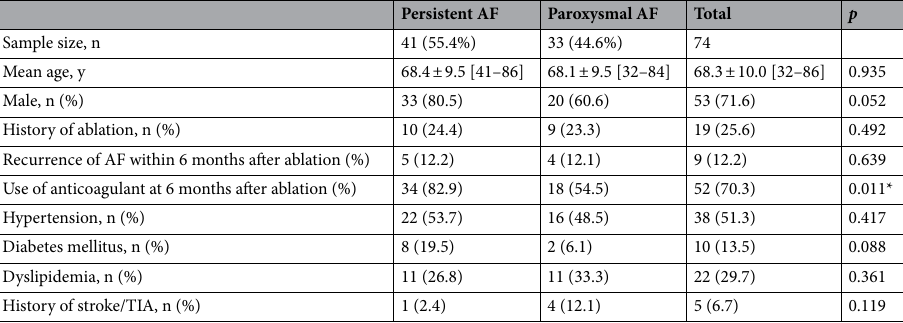
Persistent AF Paroxysmal AF Total